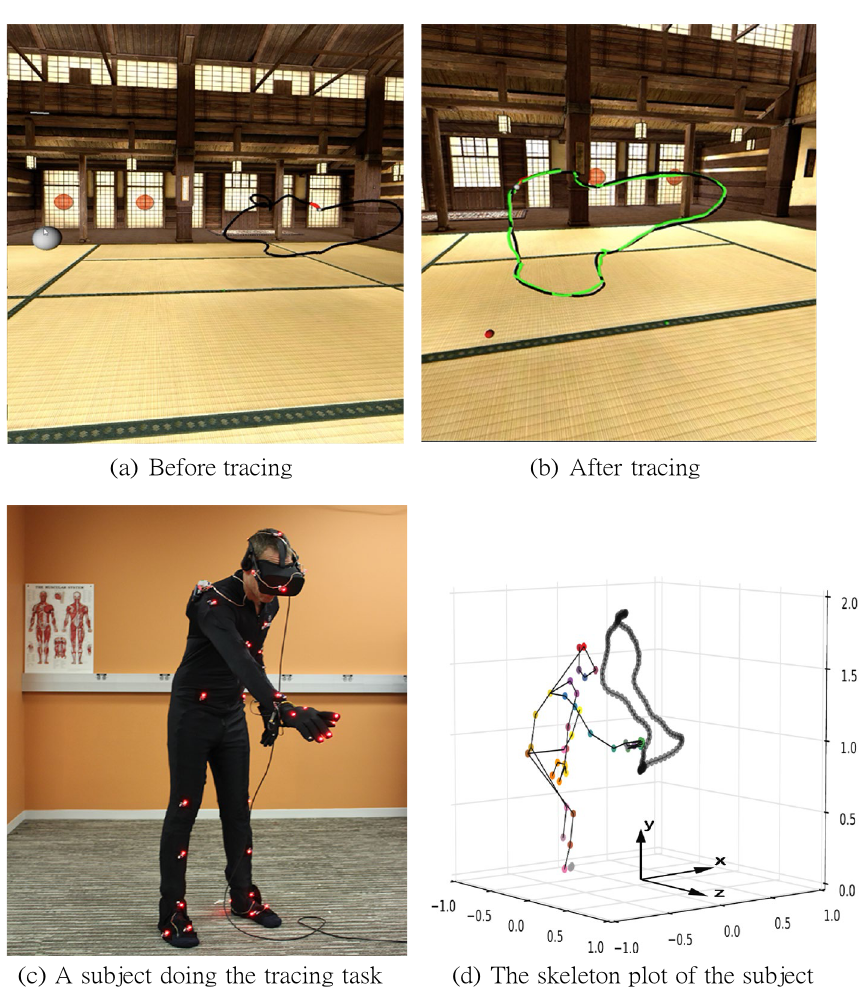
Figure 8. The virtual environment setup 26 . ( a ) Shows a full view of a path, denoted by a black path, and the starting position, denoted by a large white sphere. The small white sphere on the path at the end of a red segment is the tracing target sphere. ( b ) Depicts the scene when a trial is finished. The green path is the actual tracing trajectory generated by a subject. ( c ) Illustrates a subject in the act of tracing a path in the laboratory’s motion capture 2 × 2 × 2 meter volume and ( d ) shows the lab coordinate system. The scale on the graph is in meters. The the subject’s skeleton and the traced path in the 3D space are plotted. The color dots correspond to a subset of the fifty active-pulse LED markers on the suit and the virtual-reality